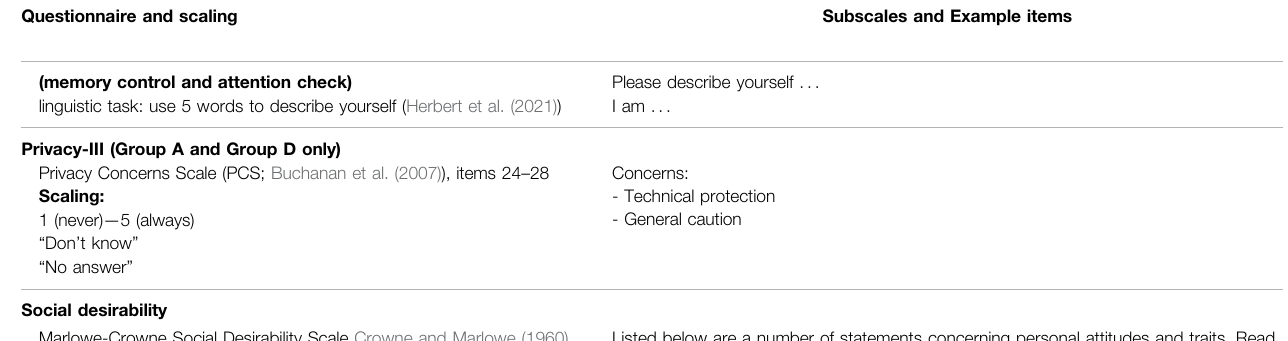
TABLE 1 | ( Continued ) Questionnaires, scaling, and items with subscales and example items. Questionnaire and scaling Subscales and Example items